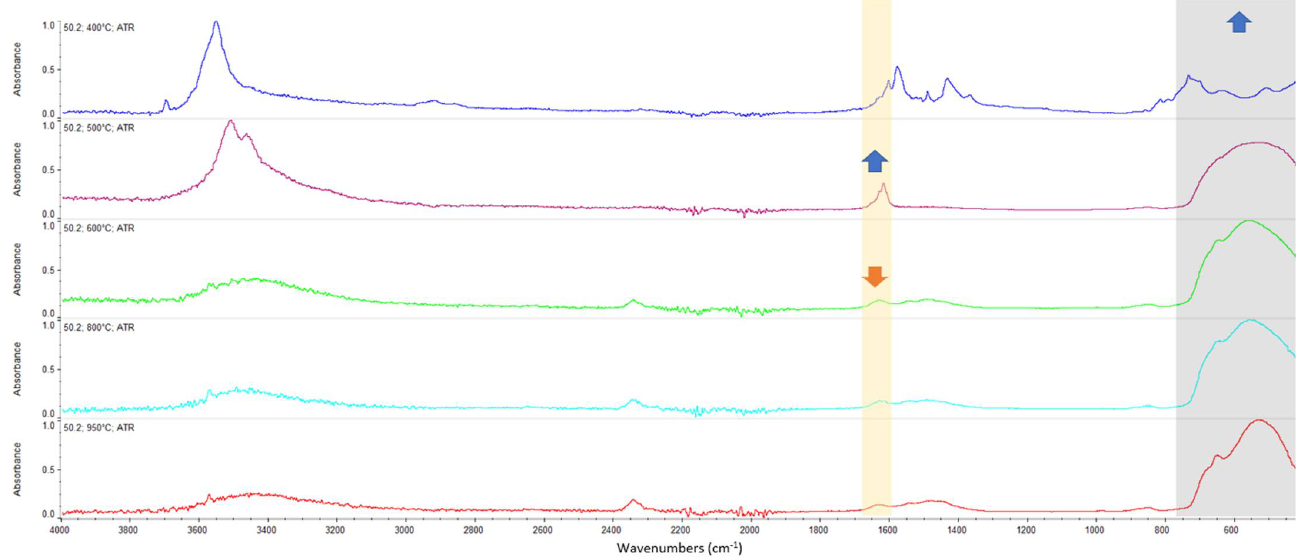
Figure A3. FTIR spectra of ashes of F50.2 at 950 °C (red), at 800 °C (light blue), at 600 °C (green), at 500 °C (purple), at 400 °C (blue).